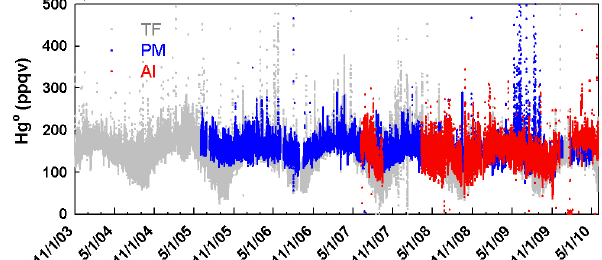
Fig. 2. Complete time series of 5-min average Hg 0 at Thompson Figure 2. Complete time series of 5-minute average Hg  at Thompson Farm (TF) Farm (TF) (gray), Pac Monadnock (PM) (blue), and Appledore Is- (gray), Pac Monadnock (PM) (blue), and Appledore Island (AI) (red). Large enhancements at PM during the time period of May – October 2009 were data land (AI) (red). Large enhancements at PM during the time period of contaminated by local sources, which were removed in analysis. May–October 2009 were data contaminated by local sources, which were removed in analysis.